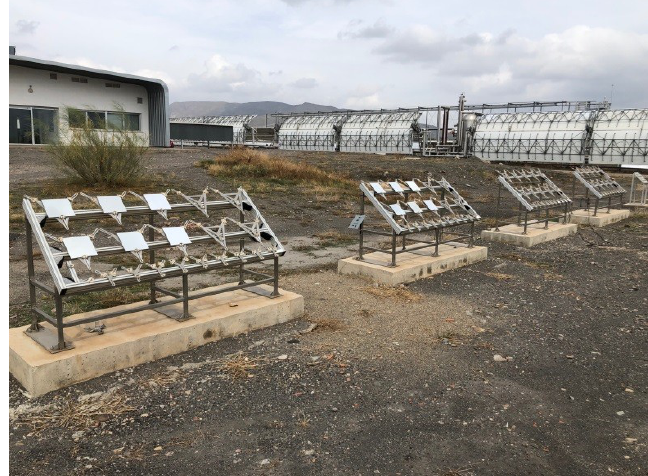
Figure 1. Exposure racks with mirror samples installed in south direction at the Plataforma Solar de Almería (PSA) facilities.